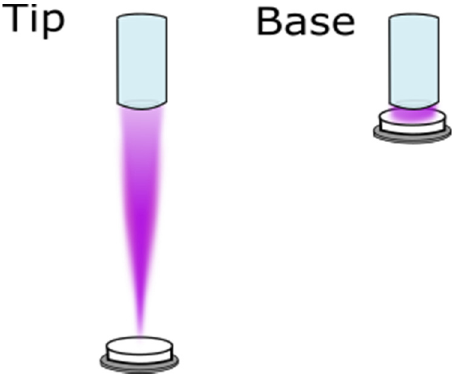
Figure 4. Tip and base treatment locations of the UHMWPE samples in the plasma plume.